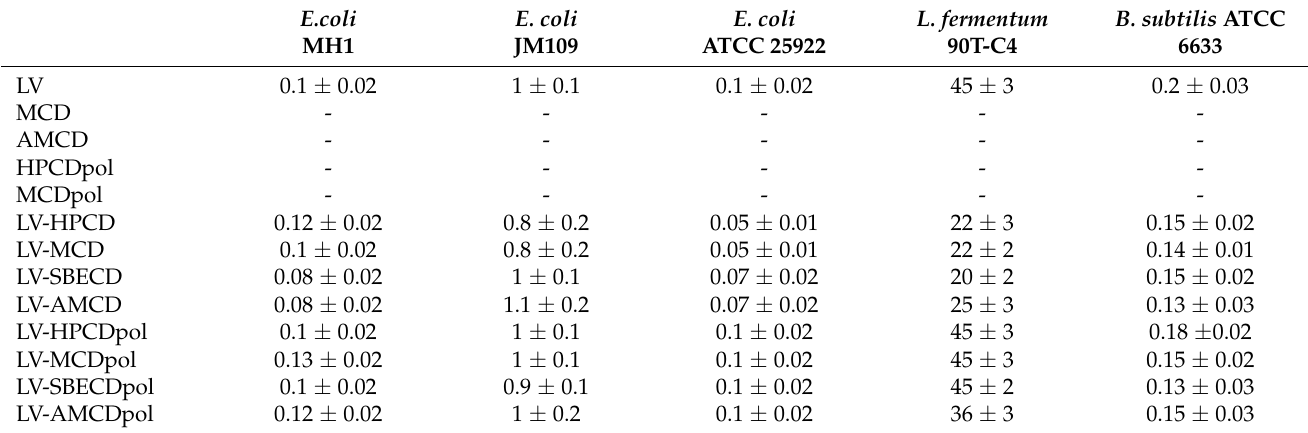
Table 2. MIC values ( µ g/mL) for LV formulations, agar well diffusion method, pH 7.4 (0.02 M Na-phosphate buffer solution), 37 ◦ C, 24 h of